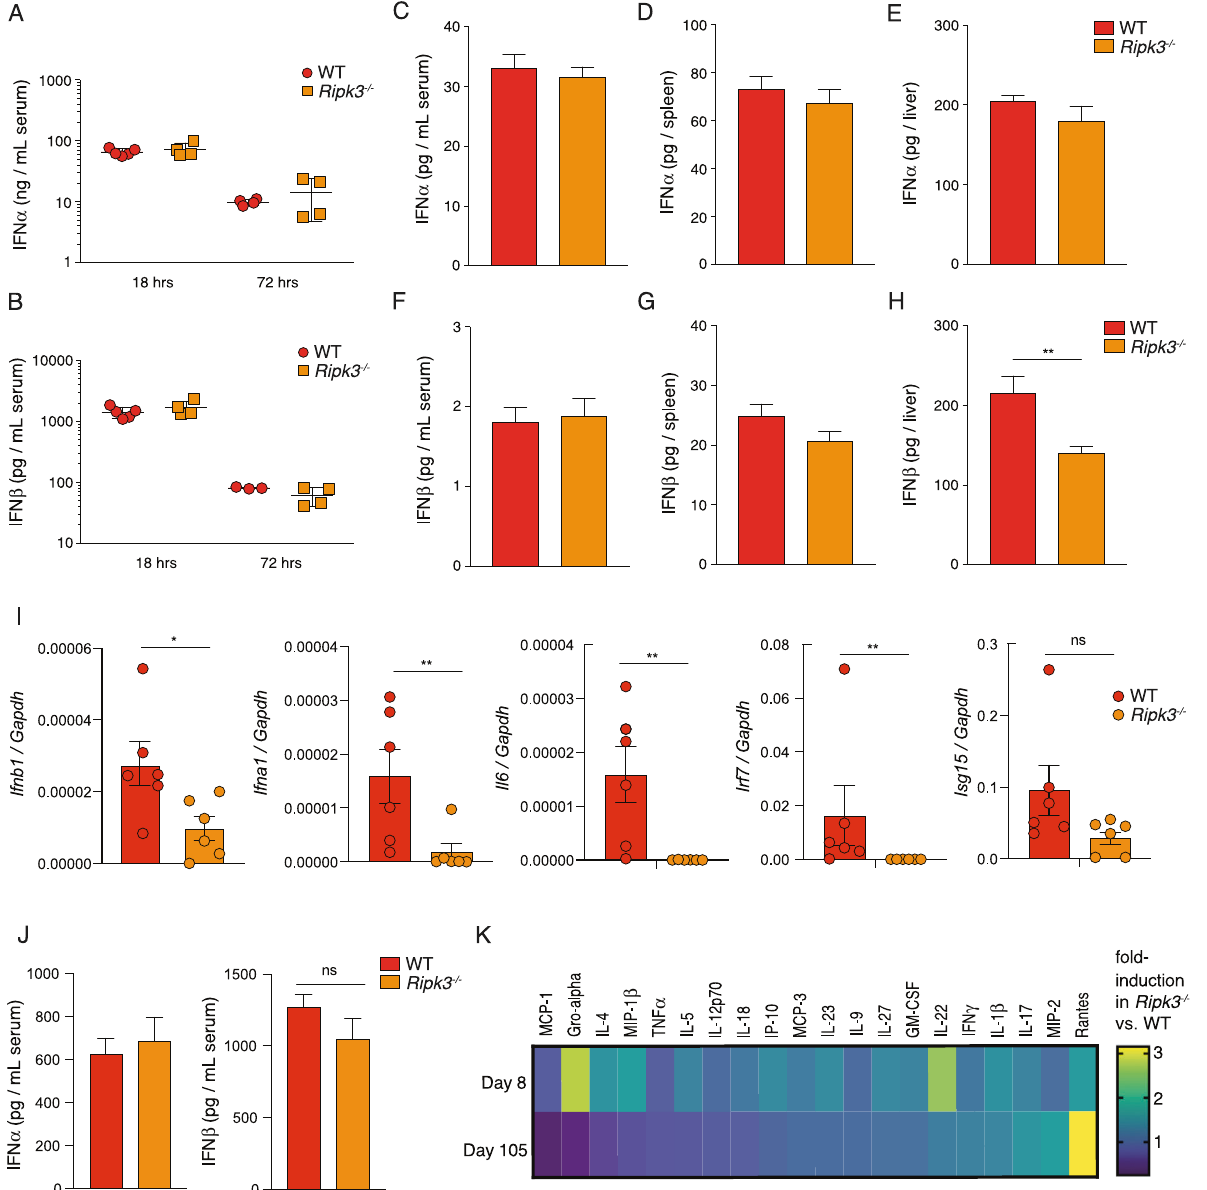
Fig. 6 Dampened IFN-I levels in livers and overall changes in circulating cytokines detected in Ripk3 -/- mice during chronic LCMV infection. Serum ( A ) IFN α or ( B ) IFN β levels were quanti fi ed by ELISA, 18 h or 72 h after LCMV docile infection. C – E IFN α or ( F – H ) IFN β levels were quanti fi ed in the serum and indicated organs 8 days post LCMV docile infection. ( C – H ) represent 8 – 9 mice per group. The mean and SEM are indicated. ** p < 0.01 (unpaired t test). HRS hours. I q-RT PCR gene expression analysis (relative to Gapdh ) of Ifnb1, Ifna1, Il6, Irf7 and Isg15 in whole livers from WT and RIPK3-de fi cient animals at 14 days post LCMV docile infection. The mean and SEM are indicated, ** p < 0.01, * p < 0.05, ns > 0.05 (Mann – Whitney U test, two-tailed). ( n = 6 mice per group). J IFN α or IFN β levels in serum of WT or Ripk3 − / − mice at 105 days post infection with LCMV docile, quanti fi ed by dual plex ELISA (per group: n = 6 WT, n = 6 Ripk3 − / − ). K Multiplex cytokine array was performed on sera collected from LCMV docile infected mice at 8 days and 105 days post infection. Heatmap represents average fold-change between WT and RIPK3-de fi cient mice at indicated time points ( n = 4 mice per genotype). and Ripk3 − / − mice. Both Ifna1 and Ifnb1 , as well as the downstram protein (MAVS). We quanti fi ed serum levels of IFN α and IFN β at several time points. WT and Ripk3 − / − mice infected with LCMV mediators Il6 , Irf7 and Isg15 were expressed at signi fi cantly lower levels in RIPK3-de fi cient animals (Fig. 6I). Aditionally, we analysed docile had similar levels of IFN-I during the early IFN-I burst the blood cytokine pro fi les both at onset of infection (day 8) as (18 – 72 h; Fig. 6A, B). At day 8 post infection, we detected a well as at late stages of infection (105 days), when marked signi fi cant decrease in IFN β levels but only slight decrease in IFN α , differences in viral clearance kinetics manifest. Similar to day 8, no in the livers of Ripk3 − / − mice compared to control animals. No striking difference was detected in serum IFN α and in IFN β at late other differences were observed in the serum or spleen (Fig. stage infection (day 105) (Fig. 6J). However, we observed overall 6C – H). We con fi rmed these fi ndings and performed qPCR analysis changes in the global pattern of circulating serum cytokines in to quantify the gene expression levels of IFN-I as well as Ripk3 − / − mice compared to control animals (Fig. 6K). This included downstream Interferon Stimulated Genes (ISGs) in livers of WT Cell Death and Disease (2023)